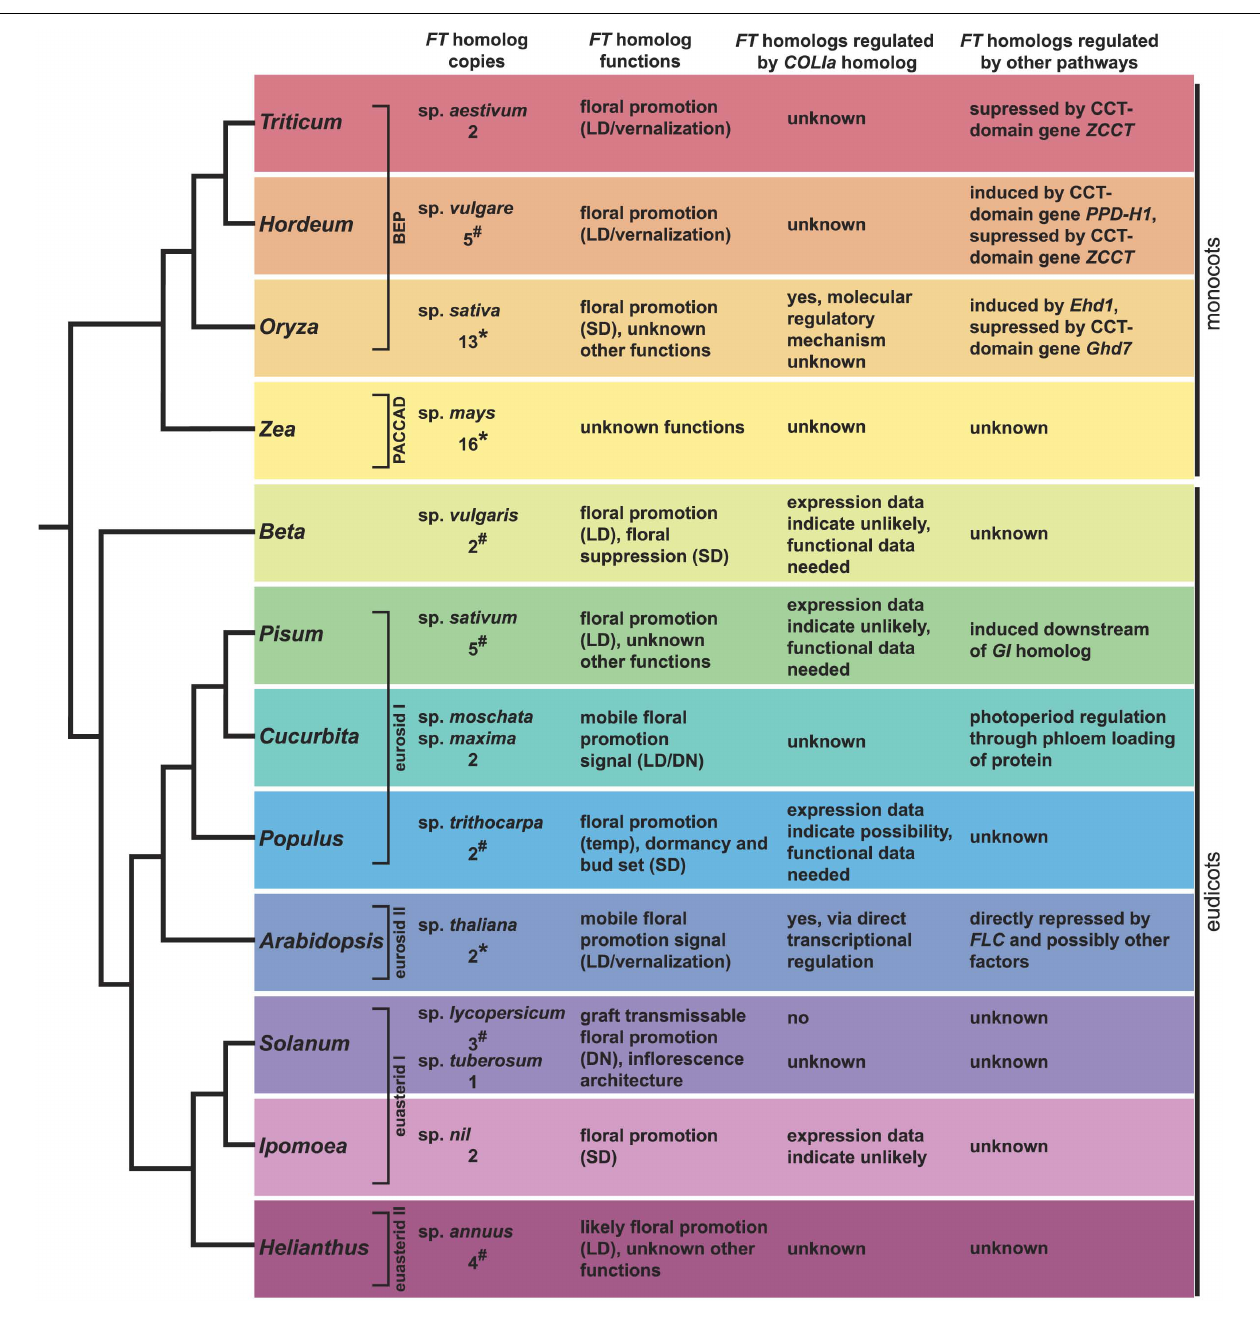
FIGURE 5 | Summary of FT and COL Ia homolog data from across angiosperms. Major angiosperm model systems discussed in the text with information on their number of FT homologs, the functions of these loci (when known), and information on their regulation. See text for relevant references. Under “ FT homolog copies,” ∗ indicates that the copy number is